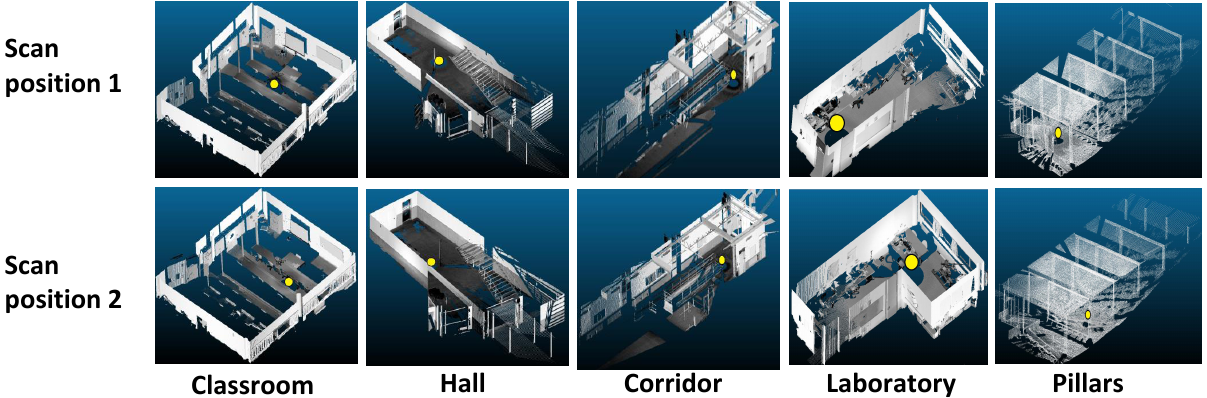
Figure 9. Datasets used during the experiments. Ceilings and walls are erased for visualization purposes. Scan stations positions are represented as yellow circles.